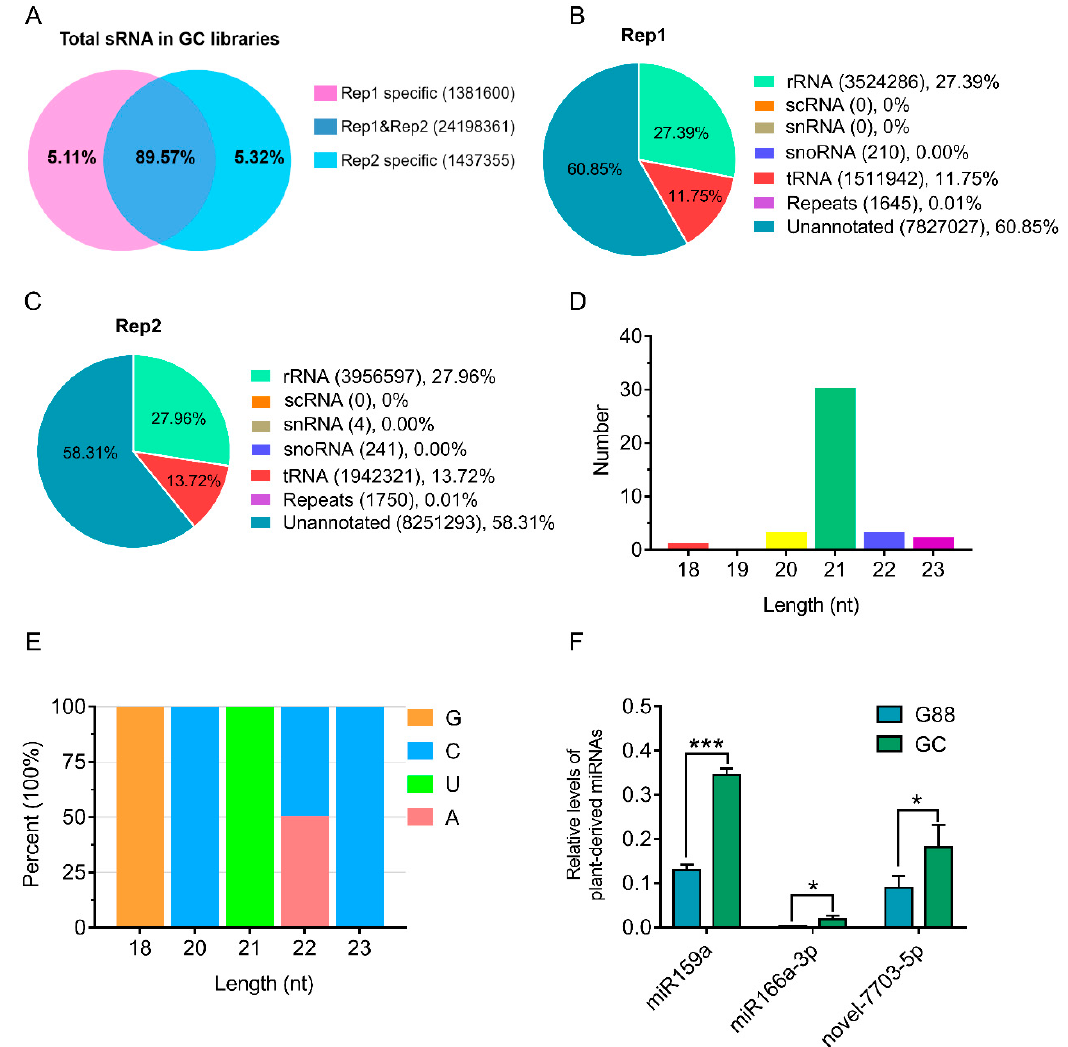
Figure 1. Plant-derived miRNAs in the larval hemolymph of P. xylostella . ( A ) Comparison of small RNA (sRNA) reads from the two replicates of GC strain libraries including common and specific reads. ( B ) and ( C ). sRNA classification ( B ) and annotation ( C ) for the two replicates of the GC strain libraries. ( D ) Length distribution of plant-derived miRNAs. ( E ) First base bias at 5 ′ -end of plant-derived miRNAs. ( F ) Quantitative real-time polymerase chain reaction (qRT-PCR) validation of miR159a, miR166a-3p and novel-7703-5p in the hemolymph of the 4 th instar larvae of the G88 and GC strains. Data were presented as mean ± SD (Student’s t test, * p < 0.05, *** p < 0.001).